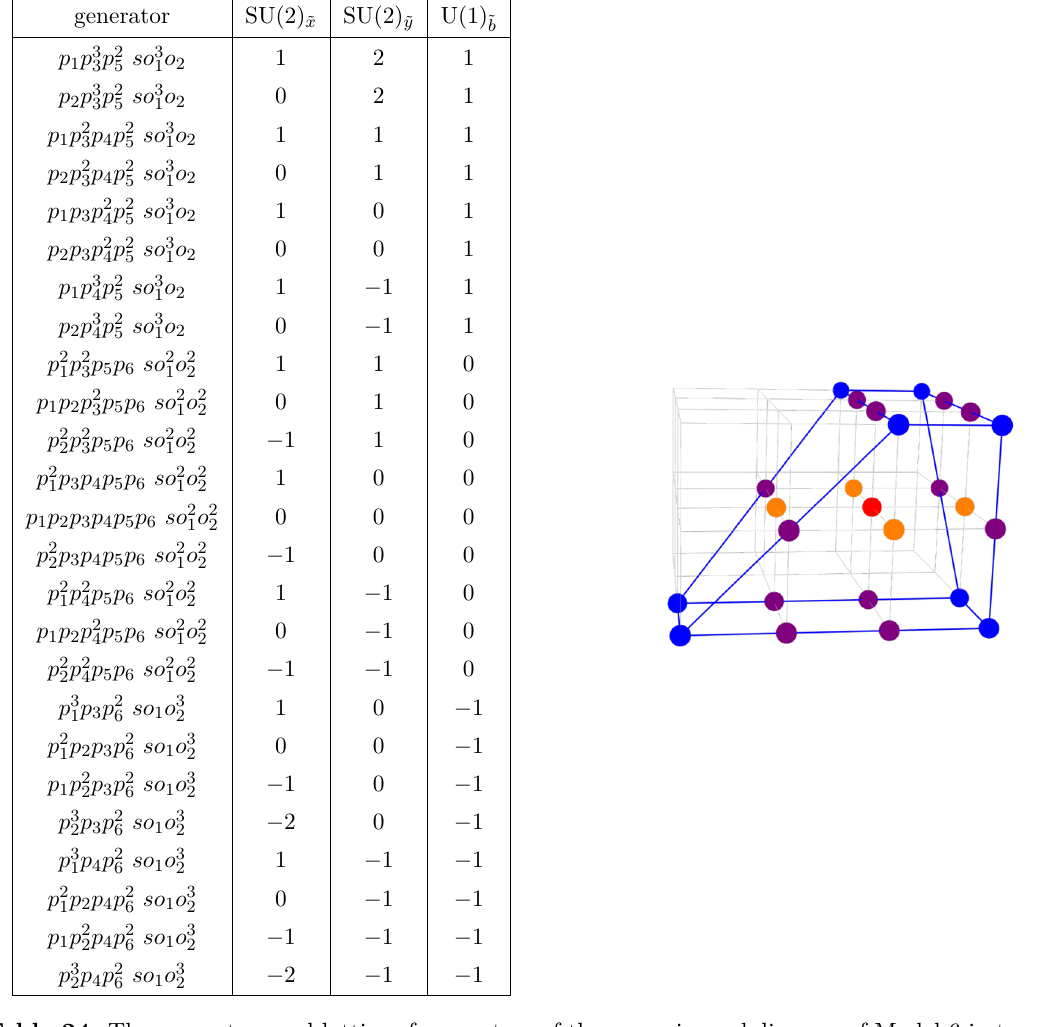
Table 24 . The generators and lattice of generators of the mesonic moduli space of Model 6 in terms of brick matchings with the corresponding flavor